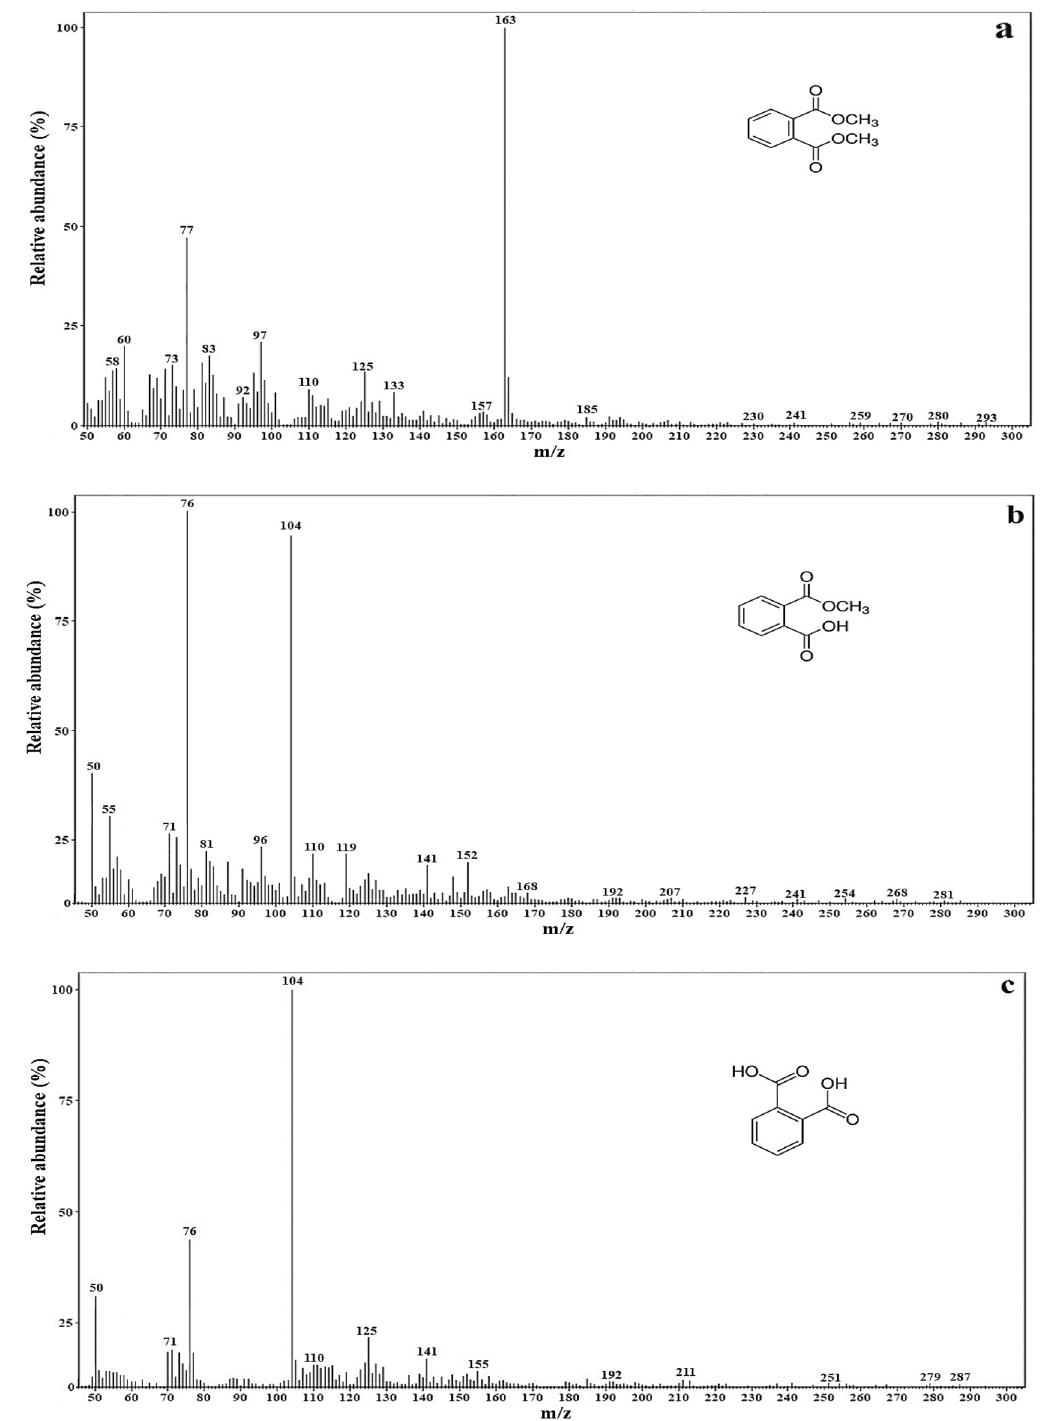
Figure 4. GC–MS fragmentation pattern representing the detection of DMP and its degradation metabolites for Micrococcus sp. KS2 [a DB-5 column (30 m × 0.25 mm × 0.25 m) with helium as carrier gas at a flow rate of 1.0 mL min −1 ; Inlet temperature 300 °C; split ratio of